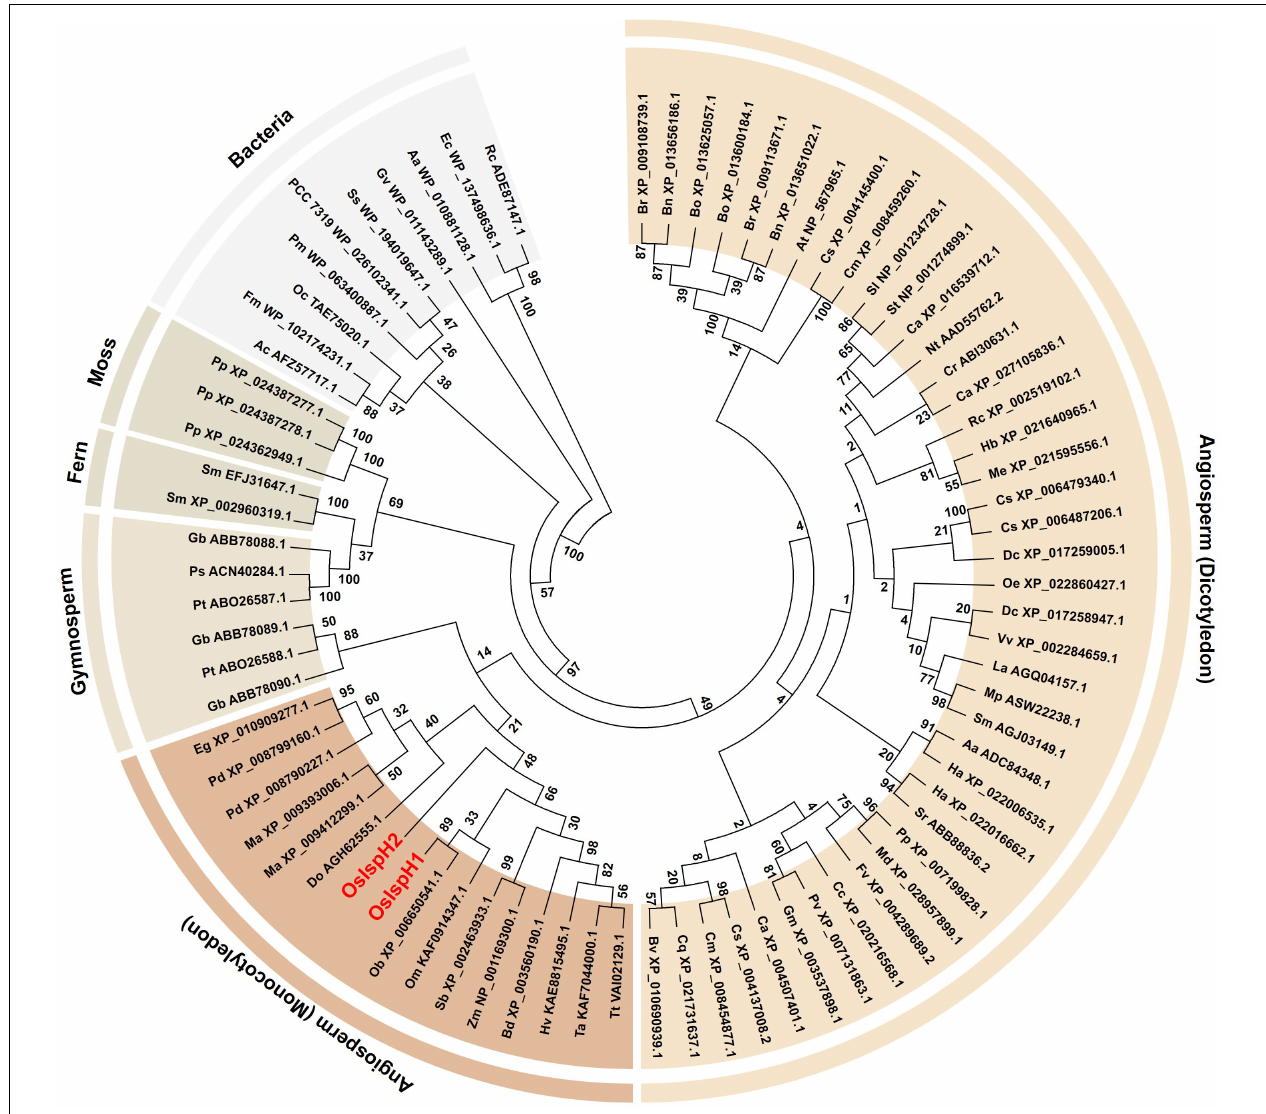
FIGURE 1 | Evolutionary relationships among isoprenoid synthesis H (IspH) families. The phylogenetic tree was inferred using the maximum-likelihood method based on the JTT matrix-based model. The bootstrap consensus tree was inferred from 100 replicates. Branches corresponding to partitions reproduced in less than 50% bootstrap replicates are collapsed. The IspH family is named by a combination of a species abbreviation and an accession number, with rice IspHs marked in red letters. Evolutionary analyses were conducted on 79 amino acid sequences using MEGA7, and Supplementary Table 1 contains all information of the IspH family used in this